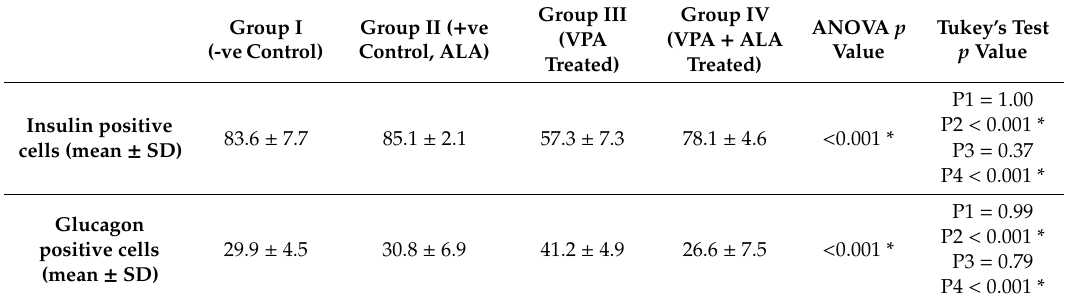
Table 1. Insulin and glucagon positive cells (mean ± SD) of control and experimental groups.